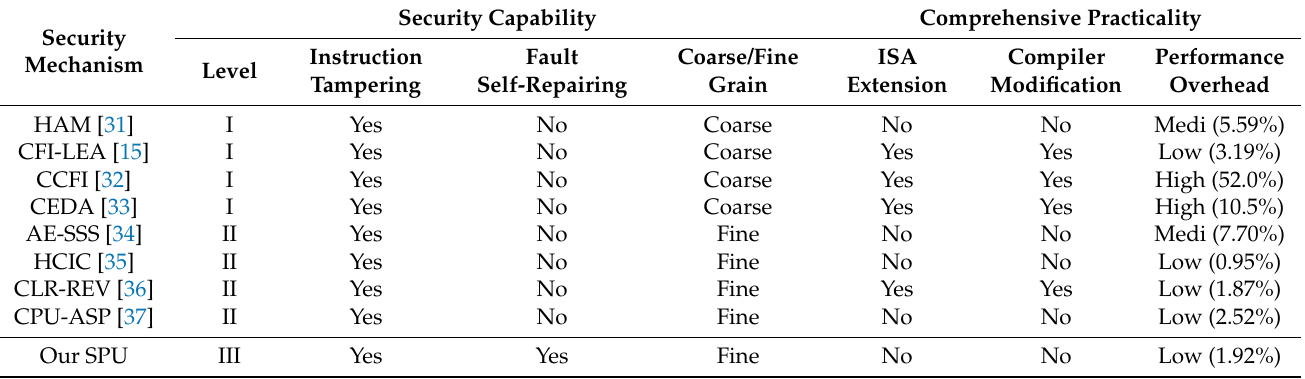
Table 5. Comparison of different security mechanisms in terms of security capability and comprehen- sive